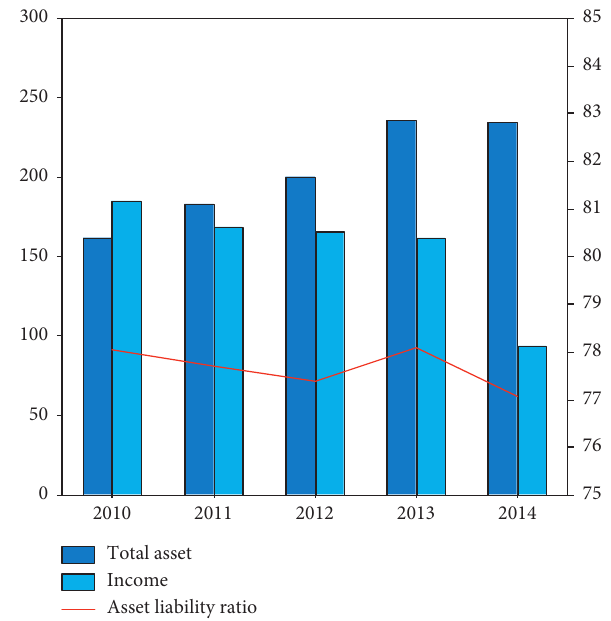
Figure 4: 2013–2016 assets and revenue of